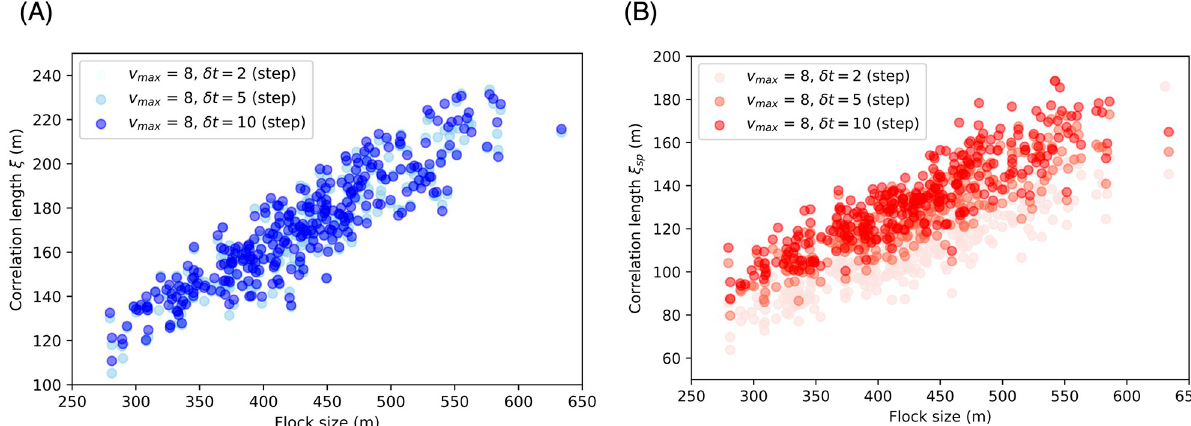
Fig 7. Relation between correlation length and flock size. The flock size is defined as the maximum distance between two agents. Instead of trajectory smoothing to cancel the agent noise, we examined the velocity vector v = x t + δ t − x t when δ t was 2, 5, and 10 steps. (A) The correlation between the correlation length ξ and flock size L , where ξ is proportional to L : ξ = aL with a = 0.40 and δ t = 2 (Pearson’s correlation test: n = 100, r = 0.93, p < 10 − 31 ), a = 0.40 and δ t = 5 (Pearson’s correlation test: n = 100, r = 0.93, p < 10 − 31 ), and a = 0.40 and δ t = 10 (Pearson’s correlation test: n = 100, r = 0.93, p < 10 − 31 ). (B) The correlation between the correlation length ξ sp and L , where ξ sp is proportional to L : ξ sp = aL with a = 0.26 and δ t = 2 (Pearson’s correlation test: n = 100, r = 0.92, p < 10 − 31 ), a = 0.30 and δ t = 5 (Pearson’s correlation test: n = 100, r = 0.92, p < 10 − 31 ), and a = 0.31 and δ t = 10 (Pearson’s correlation test: n = 100, r = 0.92, p < 10 − 31 ). For the other parameter settings, see S1 Table.